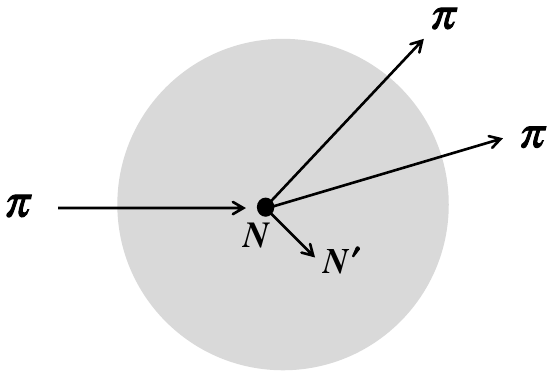
Figure 5. π − A → π − π + A ∗ process for color